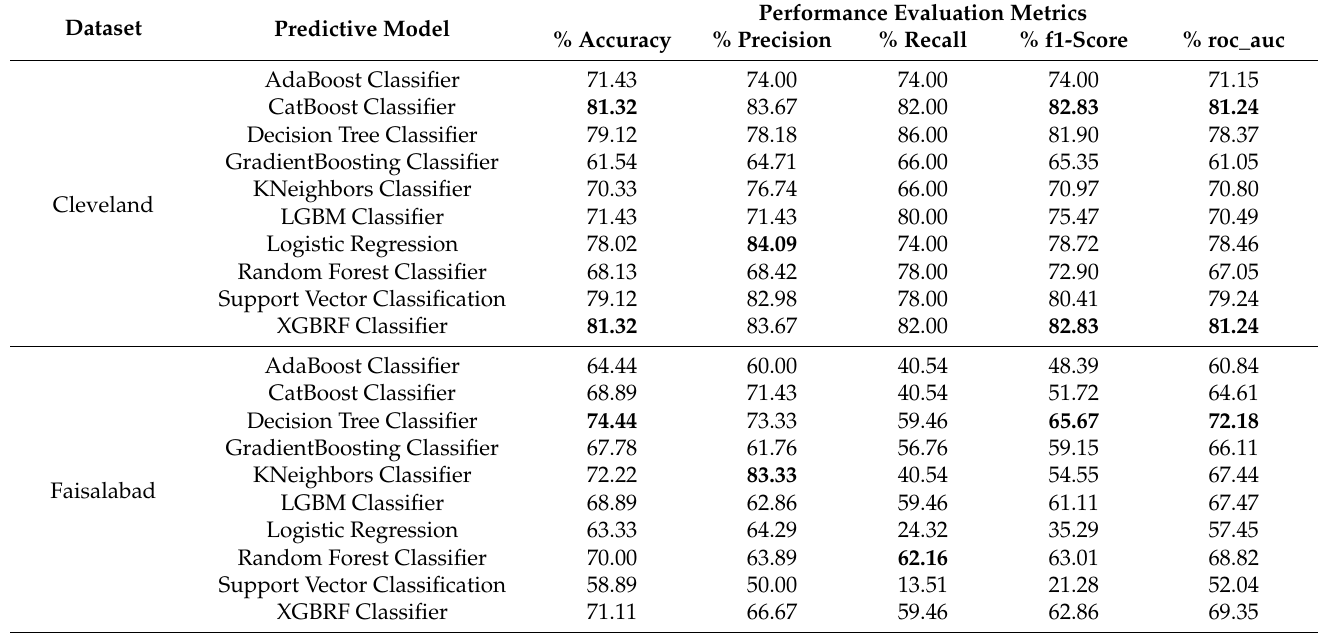
Table 7. Train-test set performance analysis of classifiers on top-two attributes from the Cleveland and Faisalabad datasets.